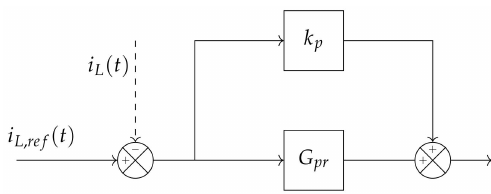
Figure 2. Block diagram of the controller, G c ( s )